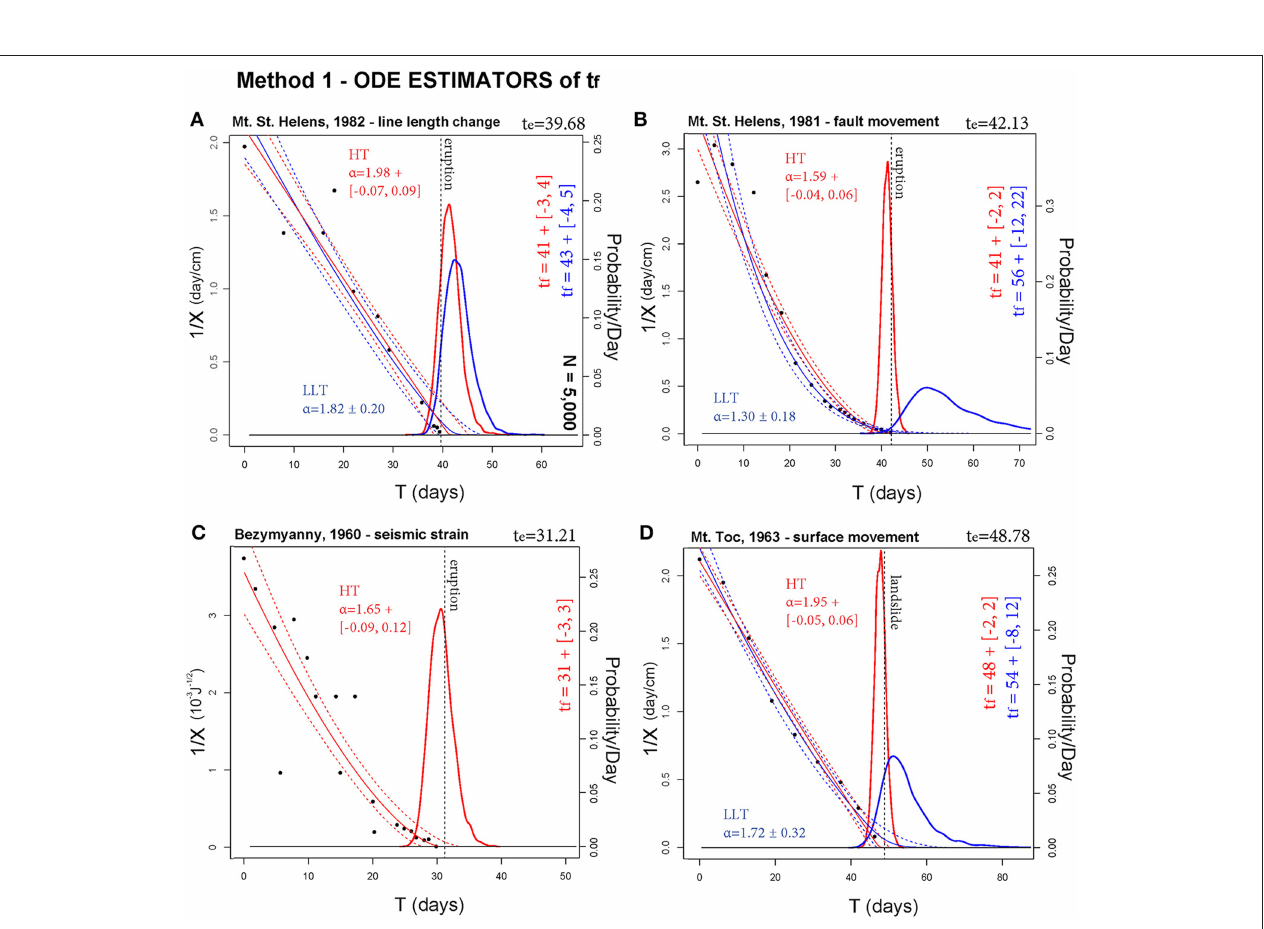
FIGURE 4 | Estimators of t f based on Method 1. In (A–D) are reported four different case studies. Blue lines assume α as from LLT, red as from HT. The bold line is g t . The probability/day scale bar is related to g t . Thin dashed lines bound the 90% confidence interval of the ODE paths of 1 / X , and a thin continuous line is the f f mean path. Black points are inverse rate data. A dashed black line marks t e . Method 1 generally provides a good estimator of t e , but often only the HT analysis allows these robust estimates because of the lower uncertainty affecting α